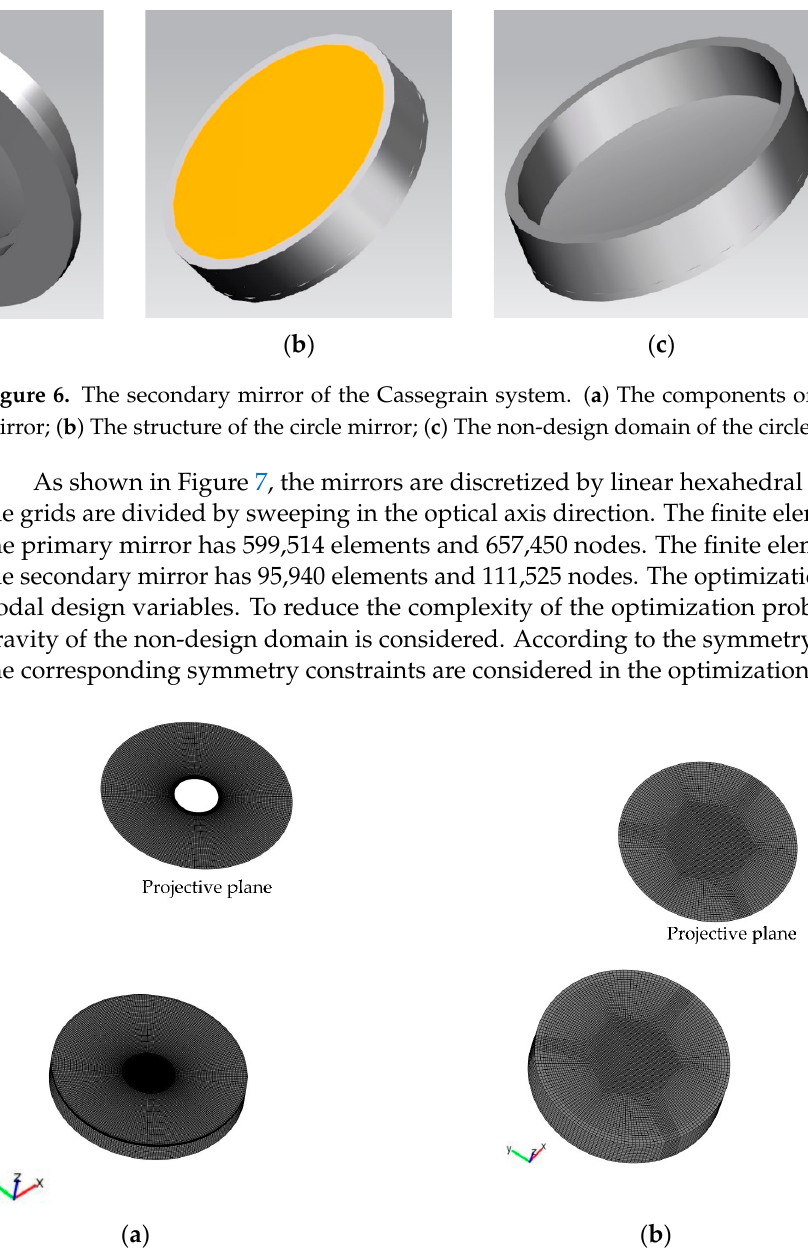
Figure 7. Finite element models of the mirrors. ( a ) The primary mirror; ( b ) The secondary mirror.